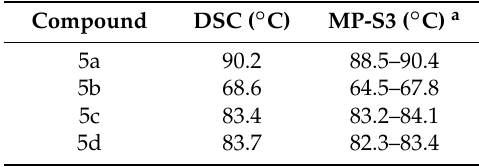
Table 3. Summary of B-L MIL melting points obtained using DSC and capillary melting point apparatus (DSC: differential scanning calorimetry, MP-S3: melting point